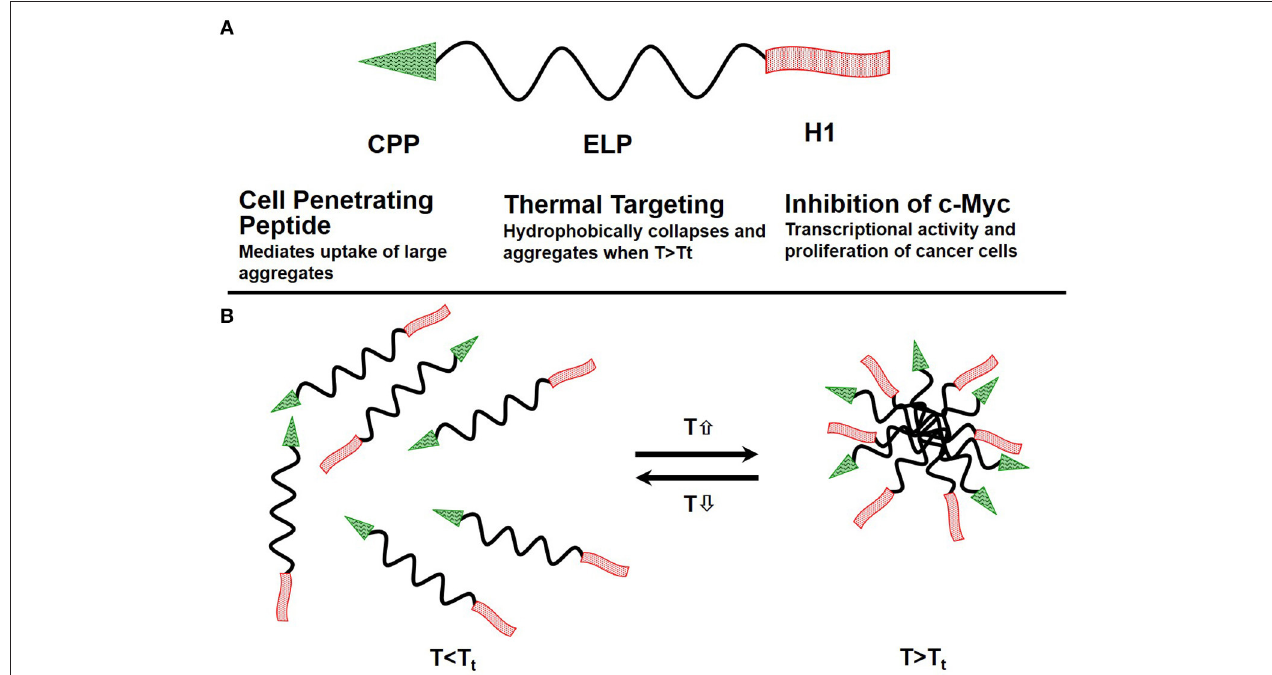
FIGURE 3 | Schematics of the ELP-based drug delivery vector . (A) The delivery system consists of the cell penetrating peptide (CPP) Bac, which promotes cellular uptake of the polypeptide, the thermally responsive elastin-like polypeptide, and a c-Myc transcriptional activity inhibitory peptide (H1), which inhibits cancer cell proliferation. (B) ELP remains a soluble monomer when the solution temperature is at or below body temperature. When solution temperature is raised above body temperature T > T t , it hydrophobically collapses and forms aggregates.